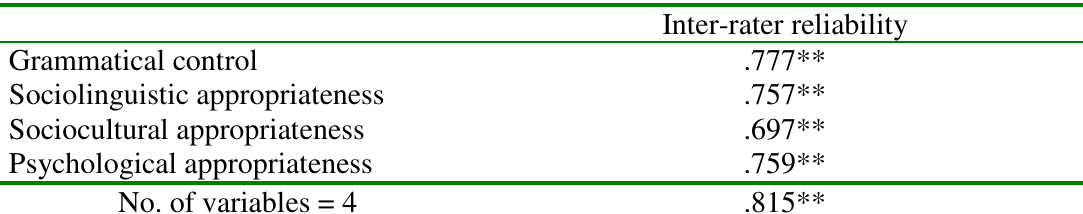
Inter-rater Reliability for the Four Language Knowledge Components (N = 90) Inter-rater